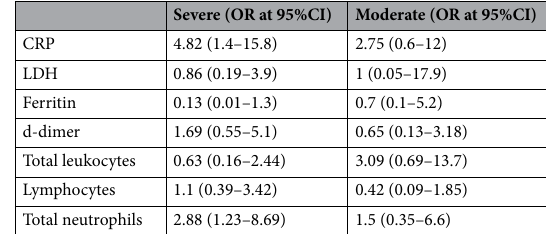
Table 2. Laboratory findings. CRP C-reactive protein, LDH lactate dehydrogenase, OR odds ratio, CI confidence